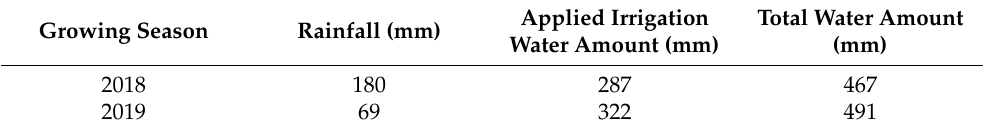
Table 2. Amounts of rainfall and irrigation in the 2018 and 2019 growing seasons.